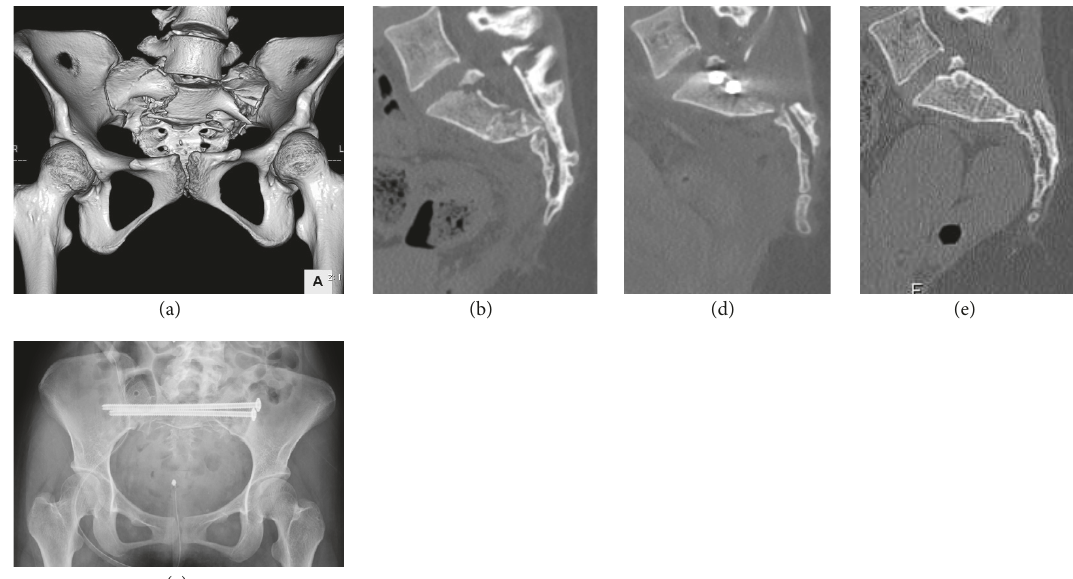
Figure 4: Case 9. An 18-year-old man who was injured from a fall from a height underwent S1 and S2 TSTI full threaded screw fixation for a Roy-Camille type 2 U-shaped transverse sacral fracture. (a) Preoperative 3-dimensional CT reconstruction of the pelvis is shown. (b) Preoperative CT scan of the sacrum in the sagittal plane is shown (preoperative sacral kyphotic angle: 89 ∘ ; fracture translation: 8 mm). (c) Postoperative anteroposterior radiograph of the pelvis is shown. (d) Postoperative CT scan of the sacrum in the sagittal plane is shown (preoperative sacral kyphotic angle: 32 ∘ ; fracture translation: 3 mm). (e) Final follow-up CT scan of the sacrum in the sagittal plane is shown. Good reduction quality was